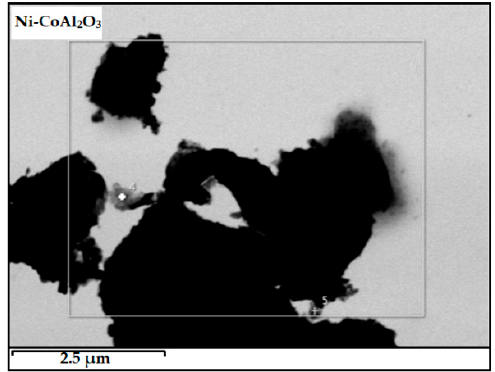
Figure 11. Morphological structure of Co/Al 2 O 4 ( A ) and Ni/Al 2 O 4 ( B ) obtained from TEM.